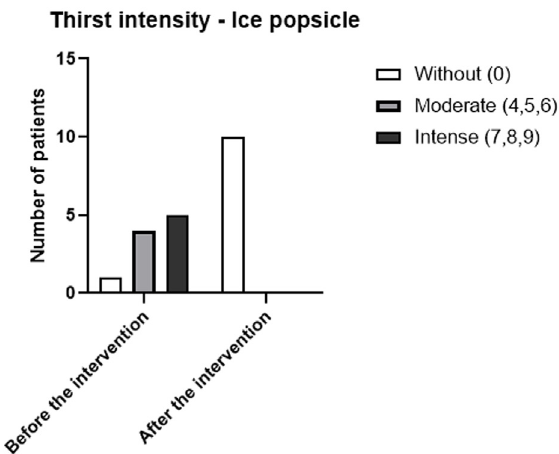
Figure 3. Evaluation of ice popsicles’ effectiveness in the intensity of thirst evocated by patients in the immediate postoperative period. Numerical verbal scale (NVS) the intensity of thirst was evaluated in the experimental group before and after the administration of ice popsicles protocol. Data are shown as the mean of five different measurements ± SD. The statistical analyses were made using column